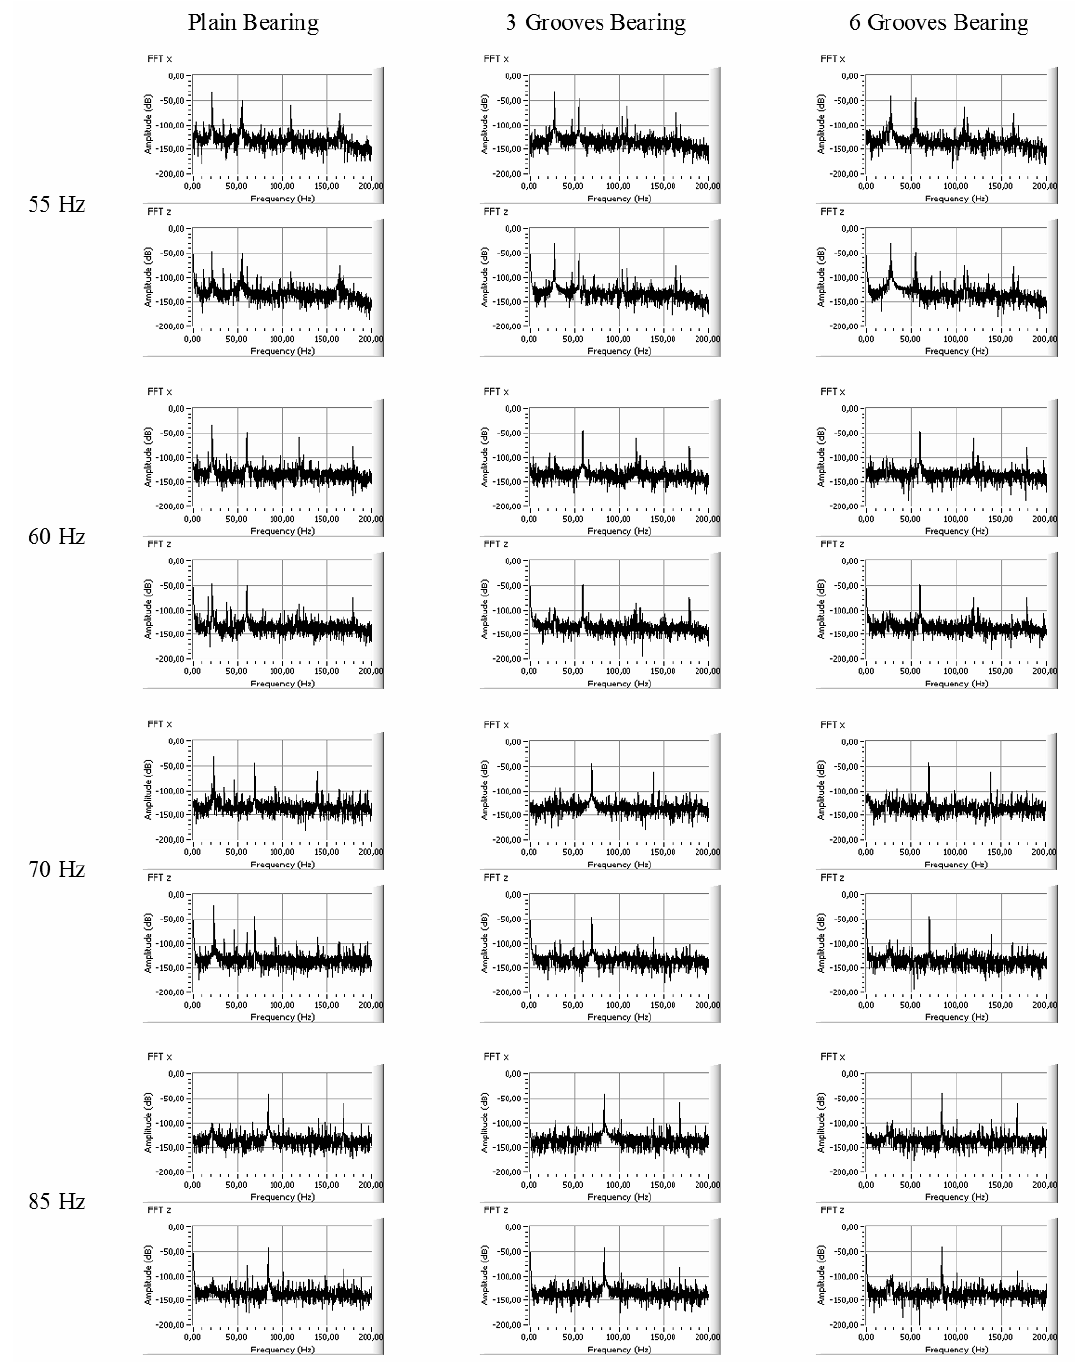
Fig. 12. Results – FFT